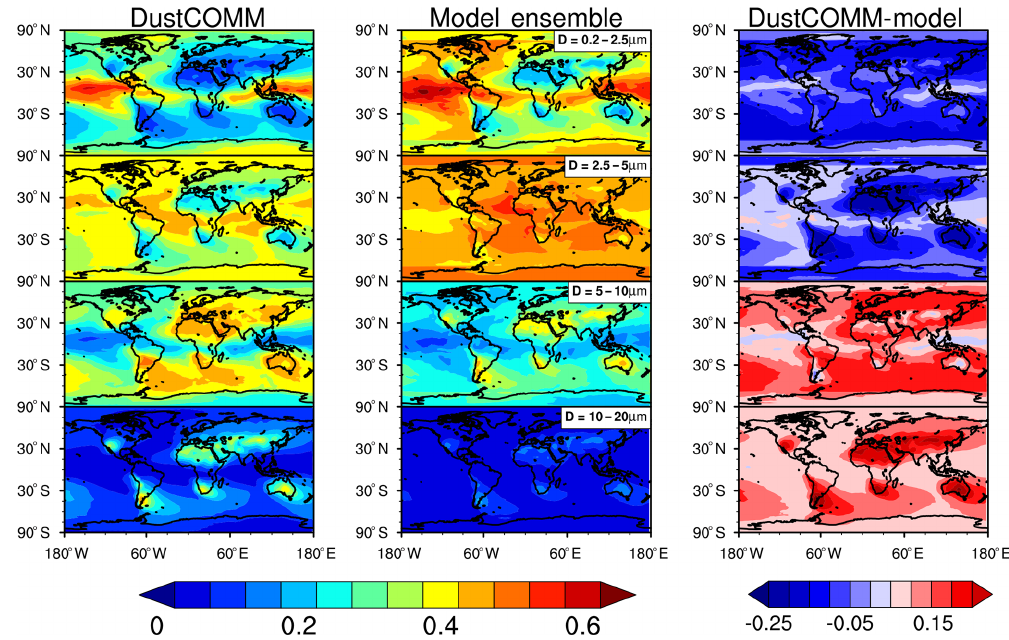
Figure 6. Differences in the spatial variability of the dust mass fraction between DustCOMM and the model ensemble. Shown are the spatial distributions of the vertically integrated dust mass fractions for different particle bins for DustCOMM (left panel), the model ensemble (middle panel), and the difference between the two (right panel; DustCOMM − model